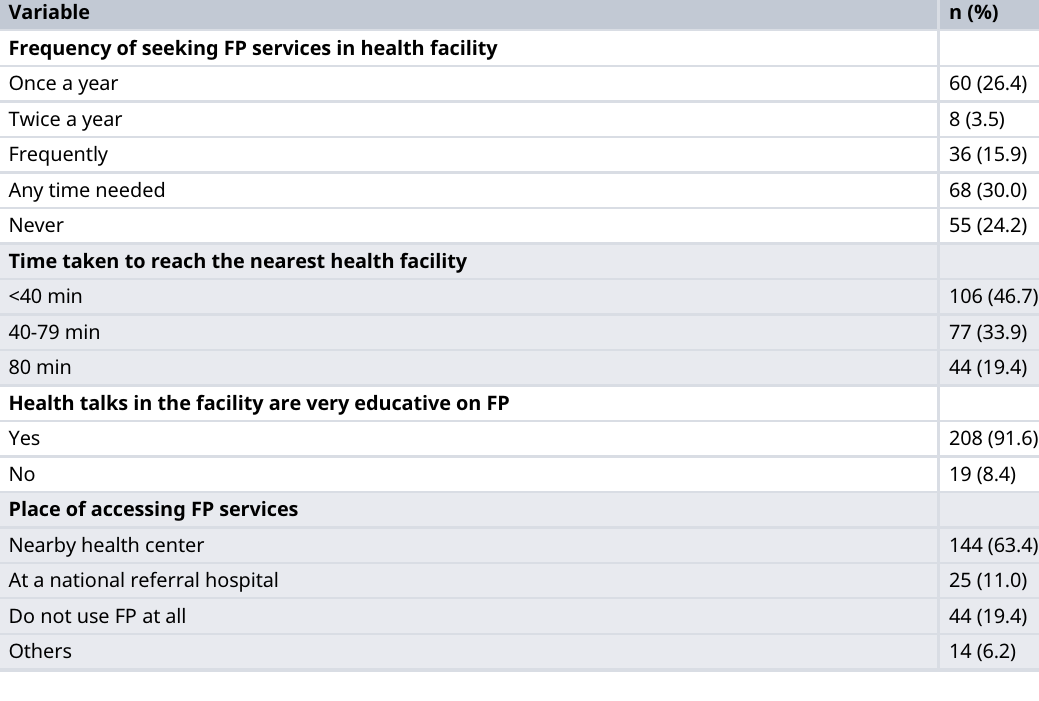
Table 3. Facility-based factors among the study participants.